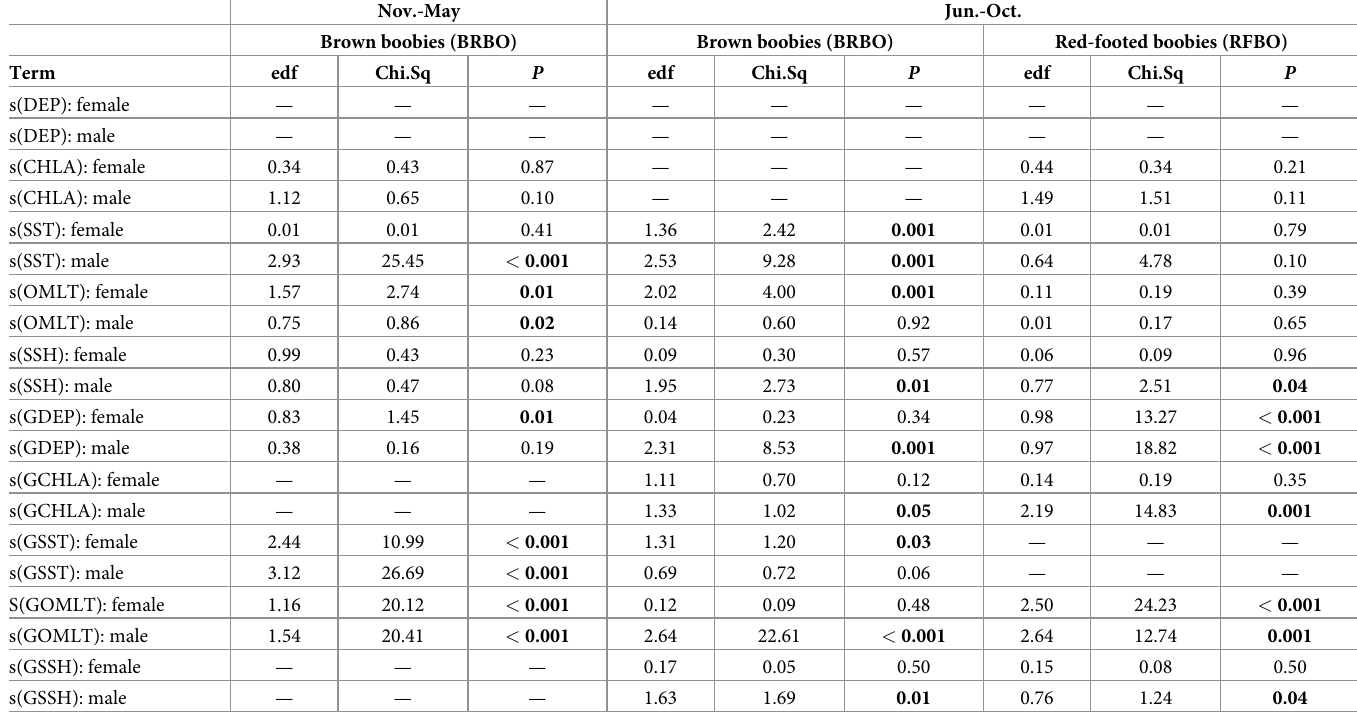
Table 2. Generalized Additive Mixed Models (GAMMs) fitted to the probability to switch between foraging (1) and travelling (0) behavioural modes of tracked individual